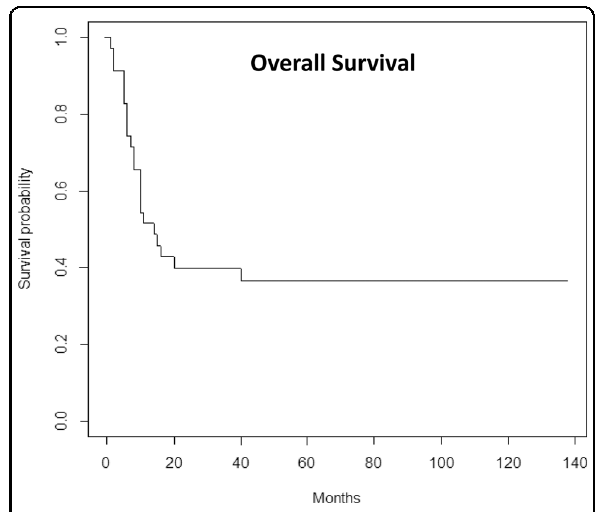
Fig. 1 Overall survival of MLFS following HSCT. Survival curve as estimated by the Kaplan-Meier product-limit method for all 35 patients undergoing allogeneic HSCT while in